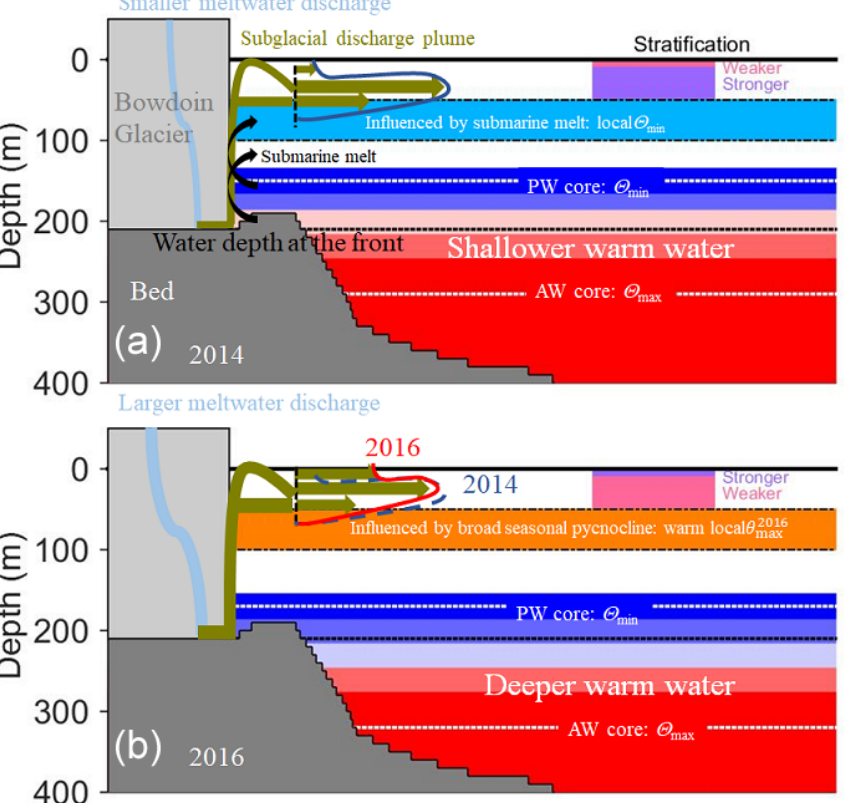
Figure 12. Schematic diagram of the possible glacial discharge and properties of vertical water mass profiles of Bowdoin Fjord in (a) 2014 and (b)